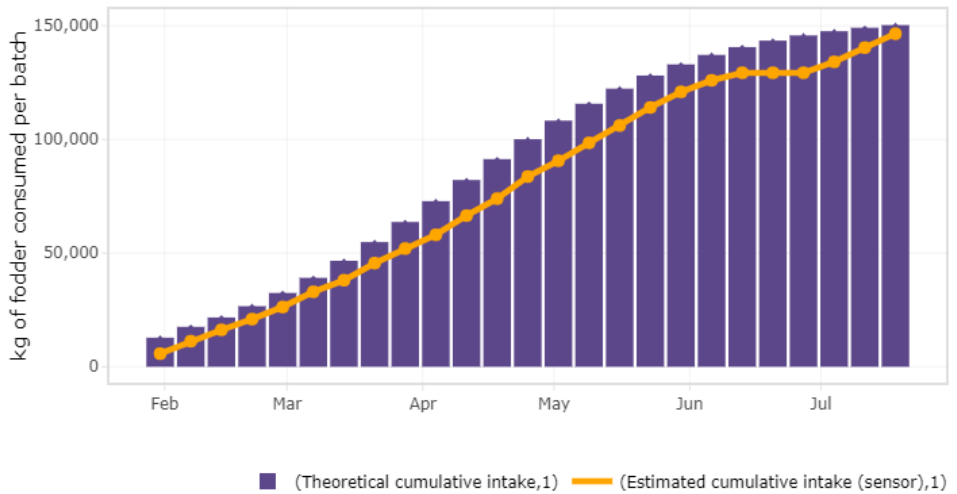
Figure 8. Cumulative feed intake of the animals in the